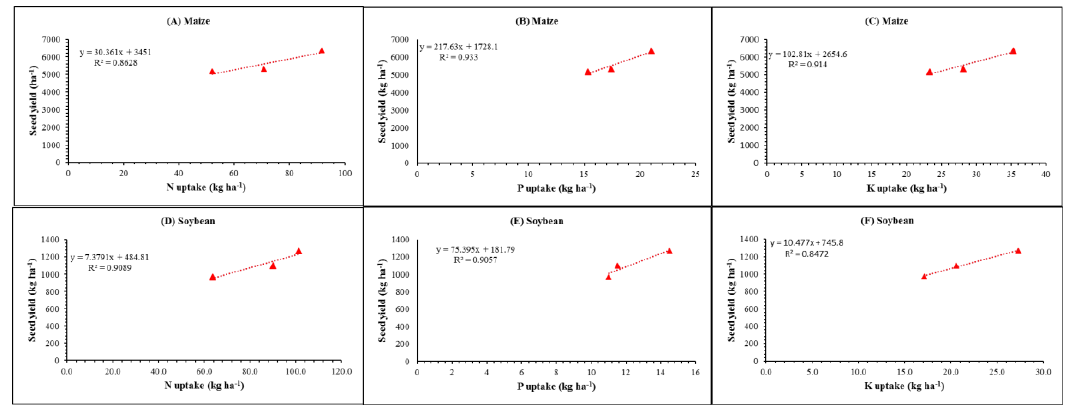
Figure 7. Relationship between seed yield and nutrient uptake of maize ( A – C ) and soybeans ( D – F ) under MSI nitrogen, phosphorus and potassium at the harvesting stage.